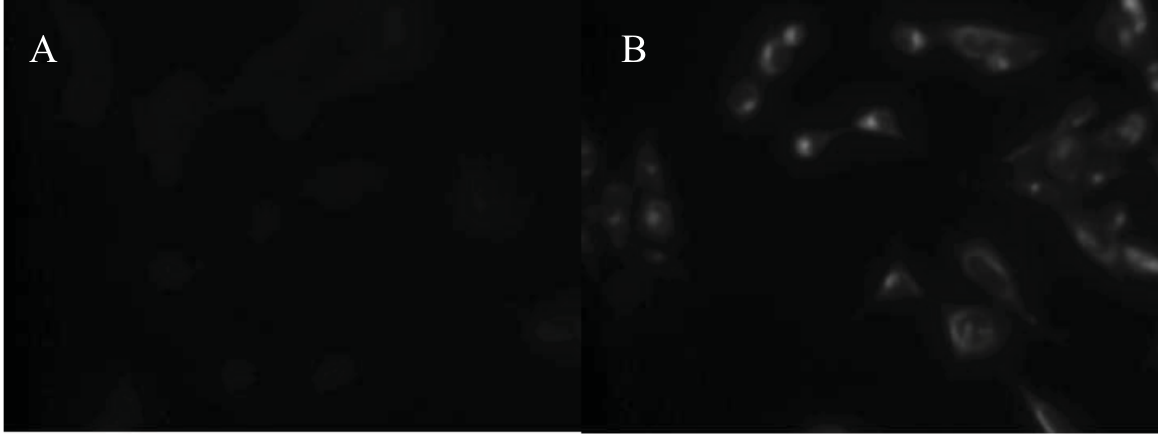
Figure 4. Interleukin-4 immunoreactivity in benign prostate tissue sections. ( A ) Hematoxylin and eosin (H & E) and ( B ) anti-IL-4 staining of benign prostate tissue; ( C ) is a positive control showing anti-IL-4 staining of tonsillar tissue; ( D ) H & E and ( E ) anti-IL-4 staining of